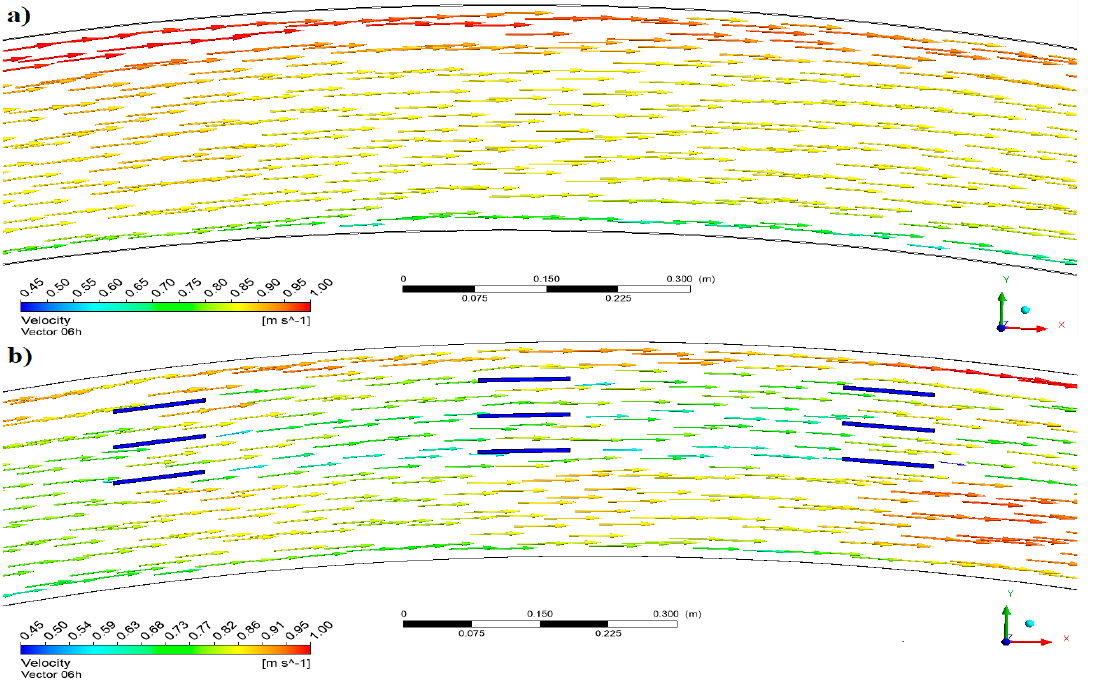
Figure 5. Velocity vectoral representation at 0.6 h for: ( a ) “without vane” situation, ( b ) “with vanes” situation.